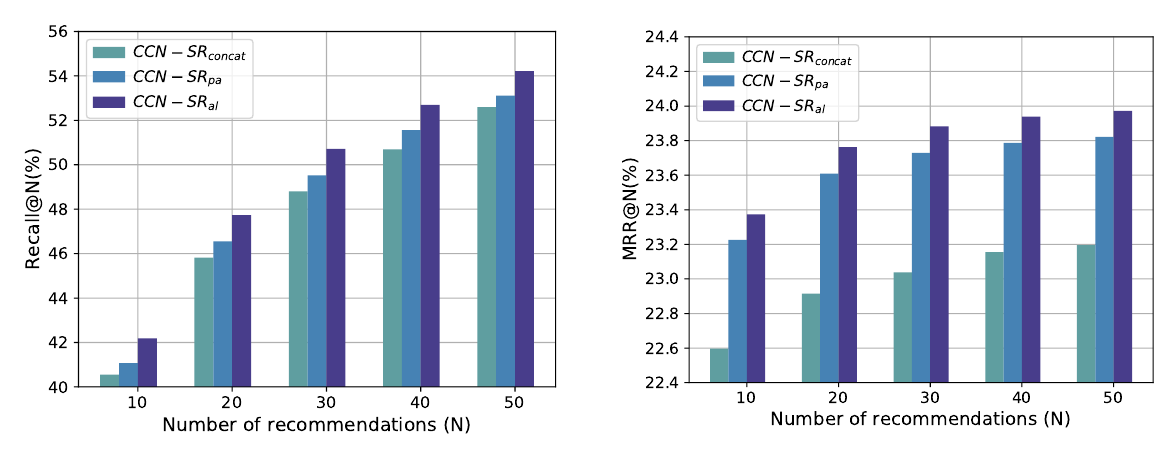
( b ) Performance in terms of MRR on Tmall.